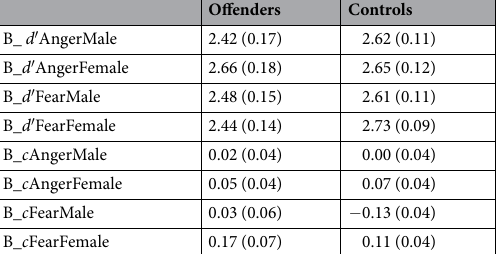
Table 3. Means (Standard Errors) of Baseline (B) Sensitivity (d ′ ) to recognize facial emotions and